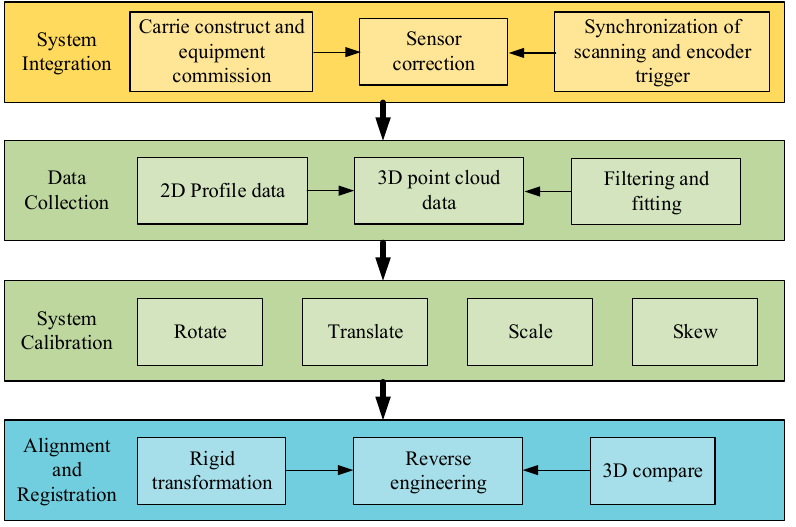
Figure 2. The block diagram of the multi-view 3D measurement process.